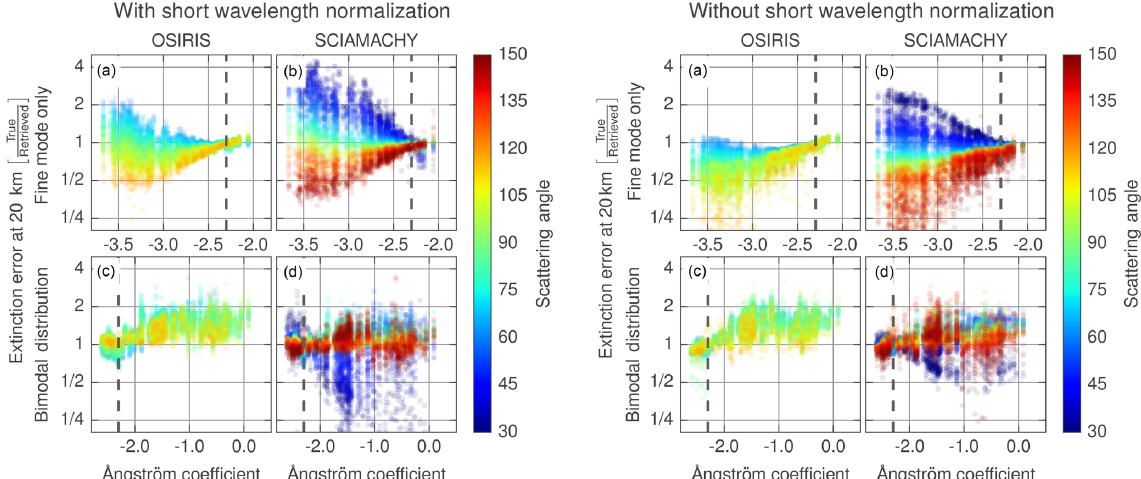
Figure 8. Error in the retrieved USask extinction as a function of Ångström coefficient at 20km. The colour of the points shows the solar scattering angle. The top row shows the error for conditions when only a fine mode of aerosol is present. The bottom row shows the error when there is both a fine- and coarse-mode distribution. The black dashed line indicates the Ångström coefficient corresponding to the particle size distribution used in the